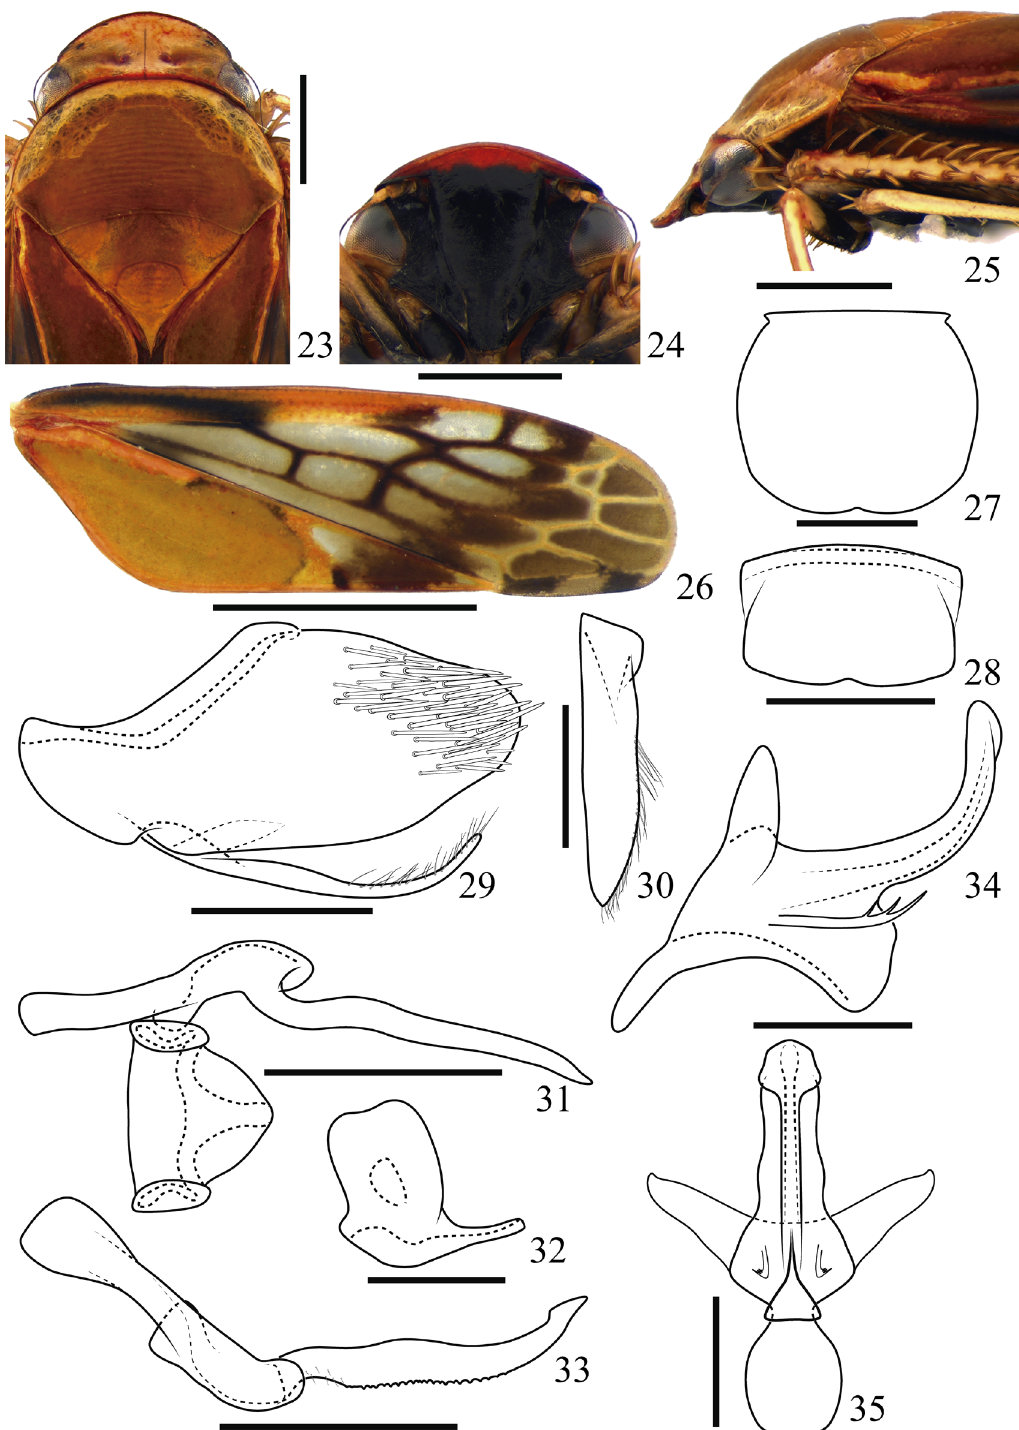
Figs 23–35. Rectapona nigrifascia gen. et sp. nov., holotype, ♂ (DZUP 215371). 23 . Head and thorax, dorsal view. 24 . Head, frontal view. 25 . Head and thorax, lateral view. 26 . Forewing. 27–35 . Male terminalia. 27 . Sternite VIII, ventral view. 28 . Valve, anterior view. 29 . Pygofer, valve and subgenital plate, lateral view. 30 . Subgenital plate, ventral view. 31 . Style and connective, dorsal view. 32 . Connective, lateral view. 33 . Style, lateral view. 34 . Aedeagus, lateral view. 35 . Aedeagus, posterior view. Scale bars: 23–25 = 1.0 mm; 26 = 2.0 mm; 27–31, 33 = 0.5 mm; 32, 34–35 = 0.25